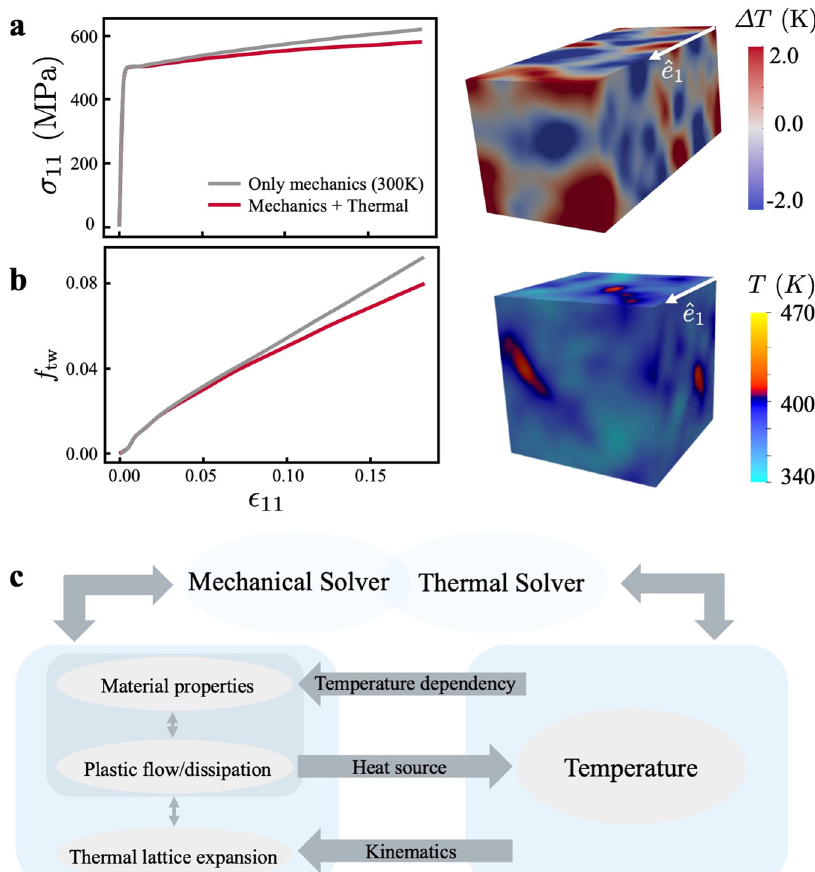
Fig. 4 Multi-physics thermo-mechanical simulation example in DAMASK. a -left Effect of plastic dissipation on the overall stress-strain response in a uniaxial tension test on bcc-iron starting at room temperature, including the effect of varying temperature on the components of the elastic stiffness tensor and the effect of lattice expansion due to increase in temperature. Simulation using the dislotwin constitutive model 198,240 where only plastic slip was considered, as implemented in DAMASK 170 . a -right Deviation in temperature for each material point from the fi nal average temperature of the simulation box. b -left Varying twin volume fraction ( f tw ) for TWIP steel assuming both isothermal response and conduction of the dissipated plastic heat causing a change in stacking fault energy and thermal lattice expansion. Simulation using the dislotwin constitutive model 240 as implemented in DAMASK 170 . b -right Final temperature in the case of conduction. c Schematics of thermo-mechanical coupling in